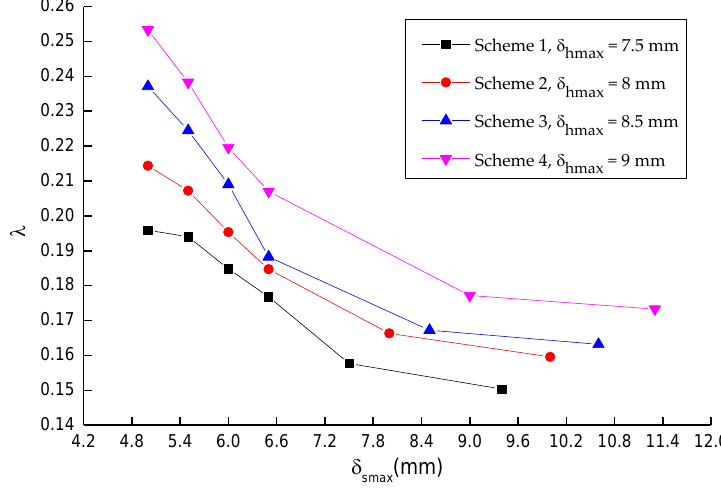
Figure 17. The variation in the aggregation degree with different thickness schemes.